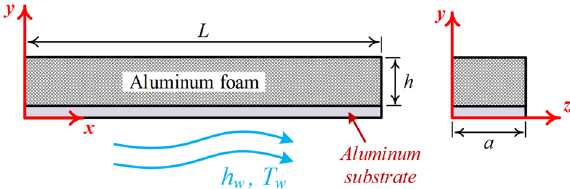
Fig. 12 Computational domain of aluminum foam coated or packed sorption bed. 3D domain used in the computational